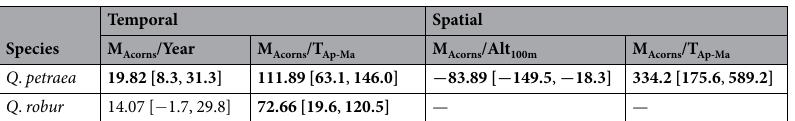
Table 1. Temperature sensitivity of reproductive efforts in oaks. Slopes of the linear mixed-effect regression between acorn production in kilograms per hectare (M Acorns ) and year (temporal gradient, (M Acorns /Year)), and for every 100 m increase in elevation (spatial gradient, M Acorns /Alt 100m ), and the mean temperature in April and May in °C (M Acorns /T Ap-Ma ) in both studies. The 95% confidence intervals are indicated in square brackets. Reproduction in Quercus petraea was monitored in both studies, whereas Quercus robur was monitored in the temporal gradient study only. Significant correlations are indicated in